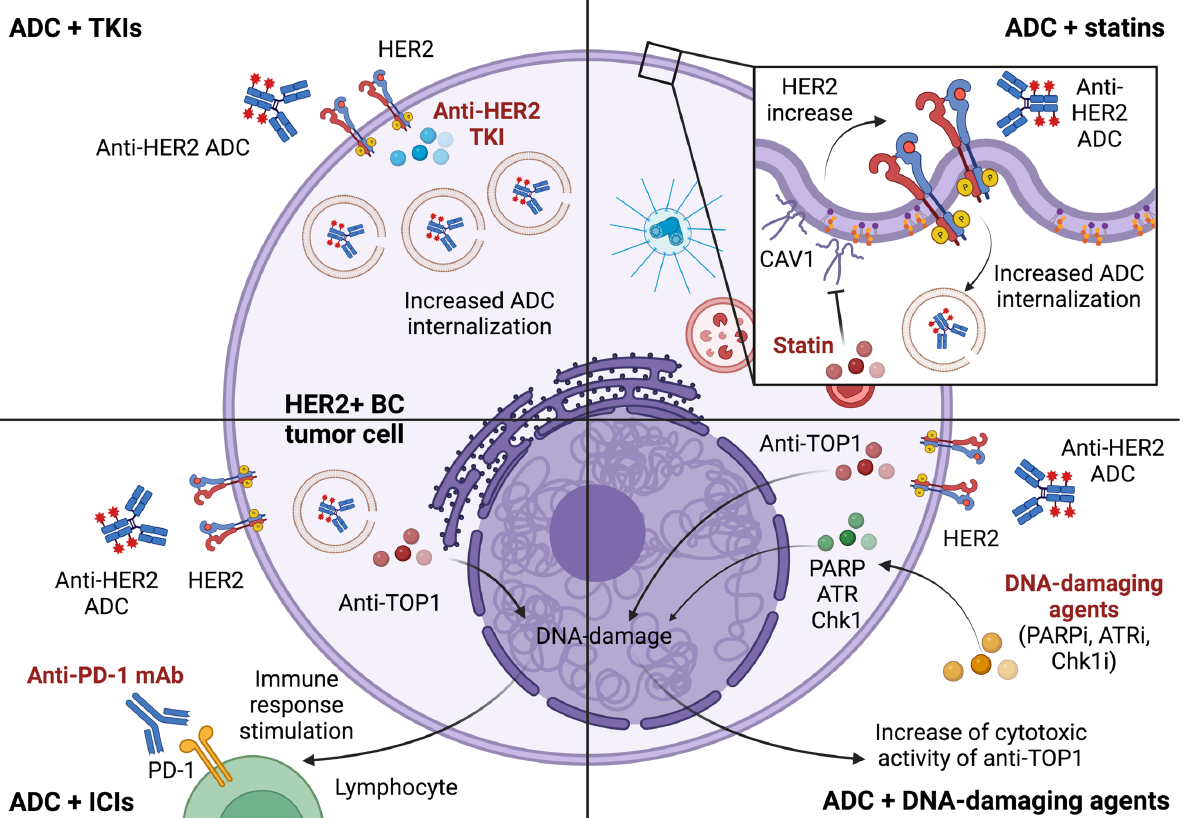
Figure 1. Combination approaches under evaluation to overcome resistance to anti-HER2 antibody- drug conjugates. Keys: ADC, antibody-drug conjugate; ATRi, ataxia telangiectasia and Rad3-related protein inhibitor; BC, breast cancer; Chk1i, checkpoint kinase 1 inhibitor; HER2, human epidermal growth factor receptor 2; ICI, immune-checkpoint inhibitor; mAb, monoclonal antibody; PARPi, PolyADP-Ribose Polymerase-1 inhibitor; PD-1, programmed death 1 protein; TKI, tyrosine kinase inhibitor; TOP1, topoisomerase 1. Created with BioRender.com.